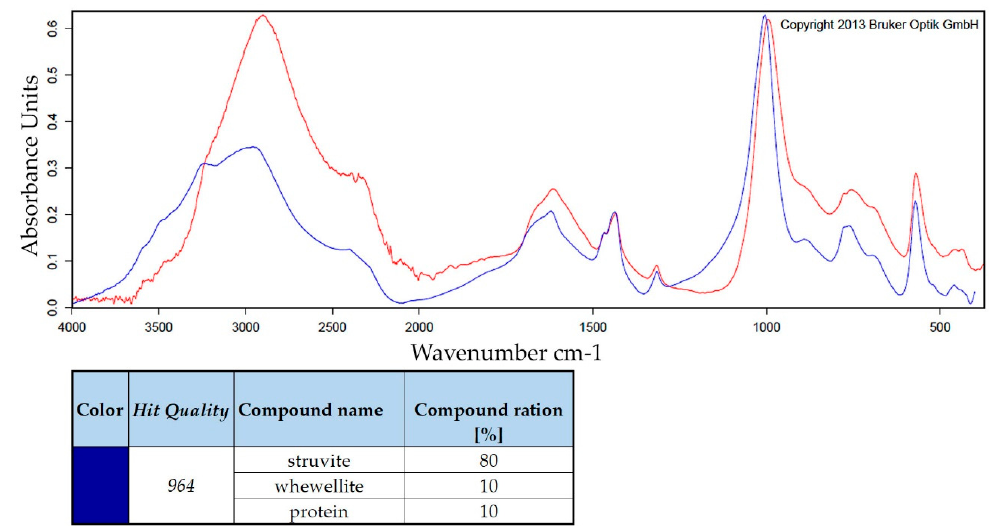
Figure 14. FTIR analysis of encrustation on an implant from the urinary bladder of a rat. For the Elastollan + barium sulphate + a-C:H/Cu-mulitilayer coating, the absorption spectrum (red) was measured and the absorption spectrum of the OPUS™ reference library had the best match (blue). Encrustation consists of struvite, whewellite and protein (80/10/10)%. In group B, implants with the Elastollan + barium sulphate + a-C:H/Cu-mulitilayer coating, a significantly higher tendency towards encrustation was observed (Figure 15). Mean values of the weights of the encrustations are as follows: group A, 1.117 g; group B, 1.994 g; effect size 0.4 (Hedges’ correction).